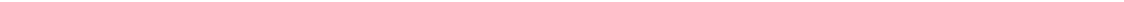
(see fi gure on previous page) Fig. 4 LyomRNA-Omicron booster immunization engendered signi fi cant immune protection. a – d BALB/c mice ( n = 10) were immunized with the inactivated vaccine (0.65 U per dose) at D0 and D21, and a booster shot with heterogeneous LyomRNA-Omicron (5 μ g) or homogeneous inactivated vaccine (0.65 U) was given at D42. The titers of plasma neutralizing antibodies against wild-type ( a ), Delta ( b ), Omicron-BA.1 ( c ), and Omicron-BA.2 ( d ) pseudoviruses were detected pre-boost, or at 14 days post boosting (dpb) and 28 dpb. e Six-year-old monkeys that had received two doses of inactivated vaccines (6.5 U dose per animal, twice at a 3-week interval) were boosted 18 months later with 50 μ g LyomRNA-Omicron. Blood samples were collected before or 7, 14, 21, and 28 days after boosting with LyomRNA-Omicron. Neutralizing antibodies against the wild-type viruses, Omicron variants BA.1 and BA.2 were tested by a VSV-pseudovirus-based system. Dotted lines represent the blood pseudovirus-neutralizing antibody titers of nonimmunized control monkeys. f , g K18-hACE2 transgenic mice were vaccinated at D0, D21, and D61 with LyomRNA-Omicron (5 μ g dose), and were lethally challenged at D73 with Omicron-BA.1. Survival ( f ) and lung virus load on D7 post challenge ( g ) were recorded. a – d The groups were compared by a two-sided Mann – Whitney test. * P < 0.05, ** P < 0.01, *** P < 0.001, **** P < 0.0001. Data are presented as the geometric means ± 95% con fi dence interval ( a – e ) or means ± SEM ( g